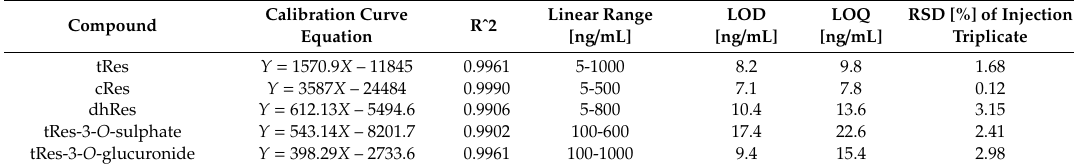
Table A2. Validation parameters of the LC / MS